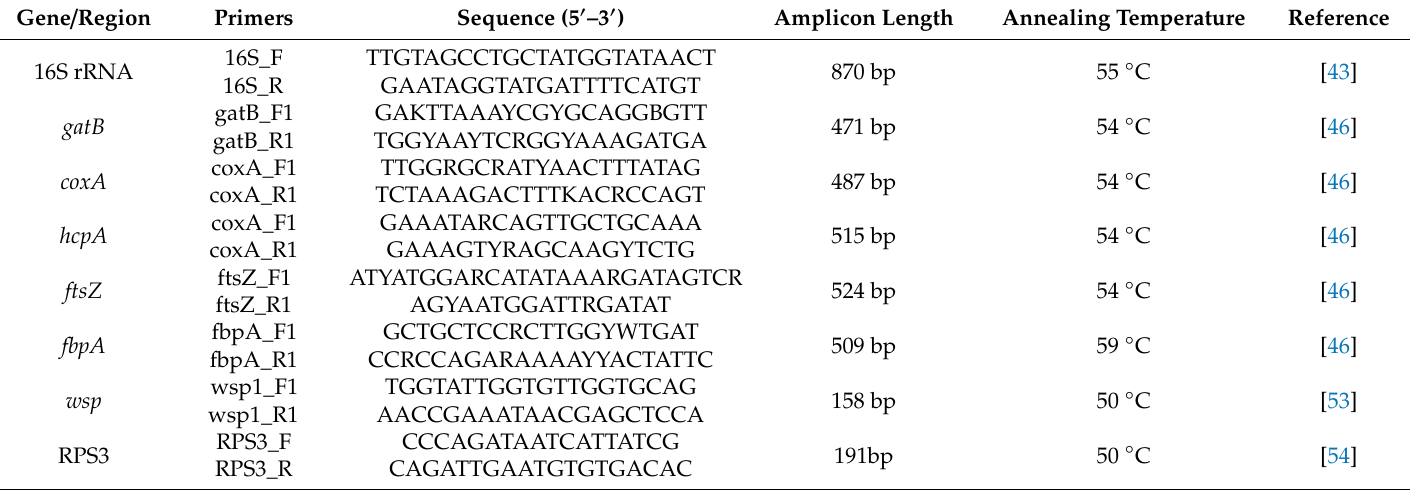
Table 1. Primer sequences and amplicon lengths of PCR products of target